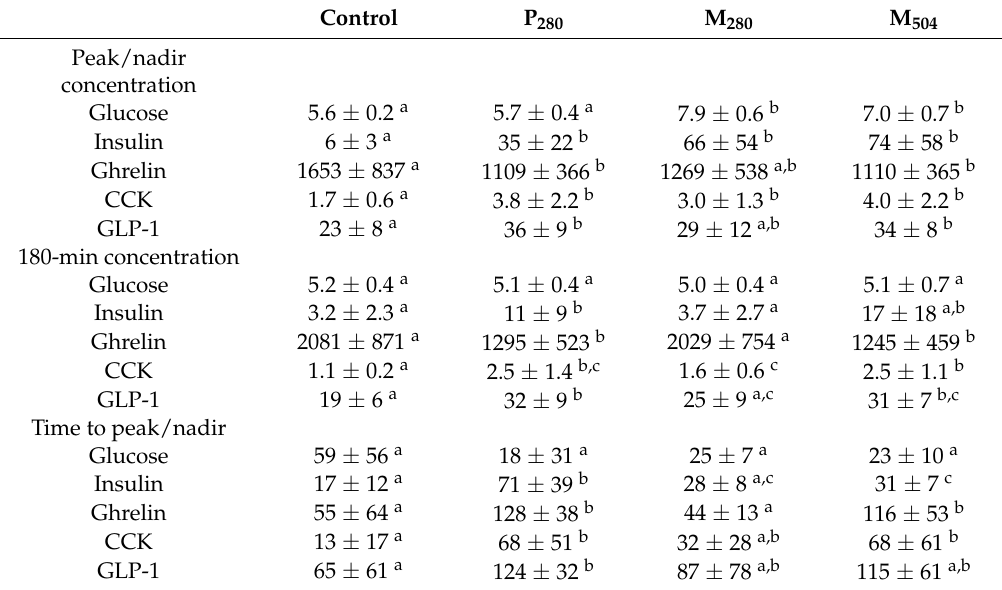
Table 3. Blood glucose and plasma hormone